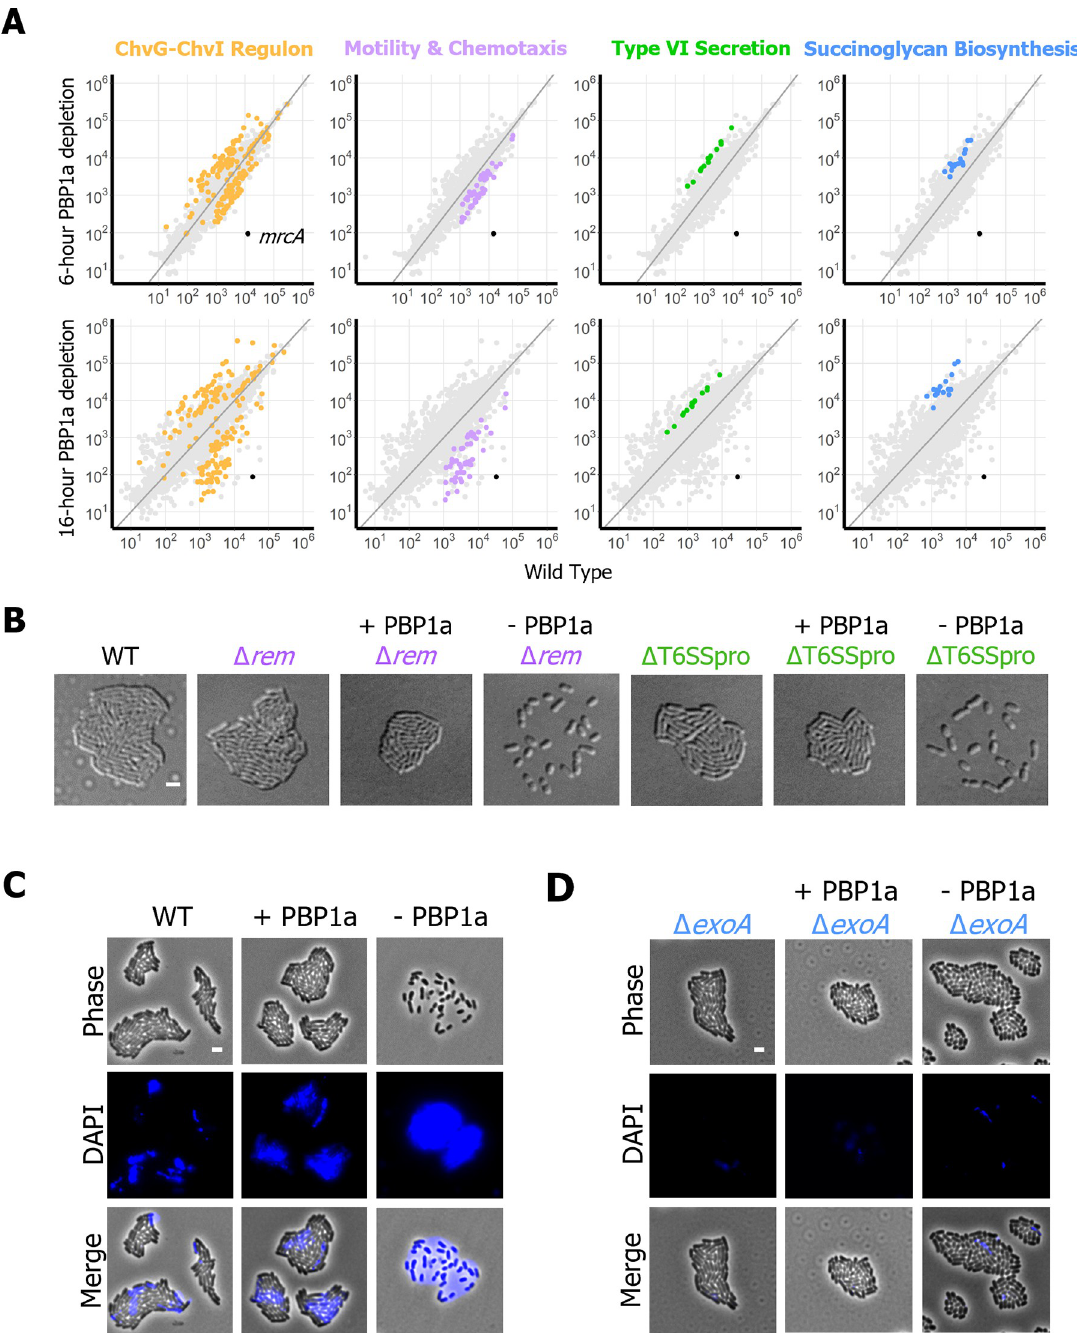
Fig 4. Succinoglycan overproduction is a conserved response to PBP1a depletion and results in failed microcolony formation. A. Scatter plots depicting RPKM values of the 6-hour and 16-hour compared to wild type. Each point represents a unique transcript. Points are colored by category. Gold, ChvG-ChvI regulon; Lavender, Motility and Chemotaxis; Green, Type VI Secretion; Blue, Succinoglycan Biosynthesis; Black, mrcA (encoding PBP1a). B. Micrographs of wild type, Δ rem , PBP1a replete Δ rem , PBP1a depleted Δ rem , Δ T6SSpro, PBP1a replete Δ T6SSpro, and PBP1a depleted Δ T6SSpro. Each strain was grown to exponential phase, spotted on a 1% ATGN agar pad containing 1mM IPTG if inducing mrcA , allowed to grow for 16 hours, and imaged by DIC microscopy. The scale bar depicts 2 μ m. C. Micrographs of wild type, and PBP1a depletion with or without IPTG inducer. Each strain was grown to exponential phase and spotted on a 1% ATGN agar pad containing 25 μ g/mL calcofluor white and 1mM IPTG if inducing mrcA . Each was allowed to grow for 16 hours and imaged by phase microscopy with and without the DAPI filter for visualizing calcofluor-stained succinoglycan. D. Micrographs of Δ exoA and PBP1a depletion Δ exoA , with or without IPTG inducer. Strains were grown and imaged as described for panel C.